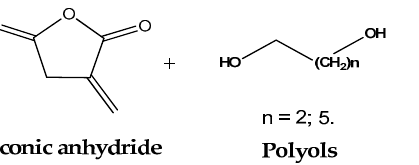
Figure 8. Esterification of itaconic anhydride with polyols catalyzed by Candida rugosa (CRL) immobilized on magnetic chitosan nanoparticles [65].